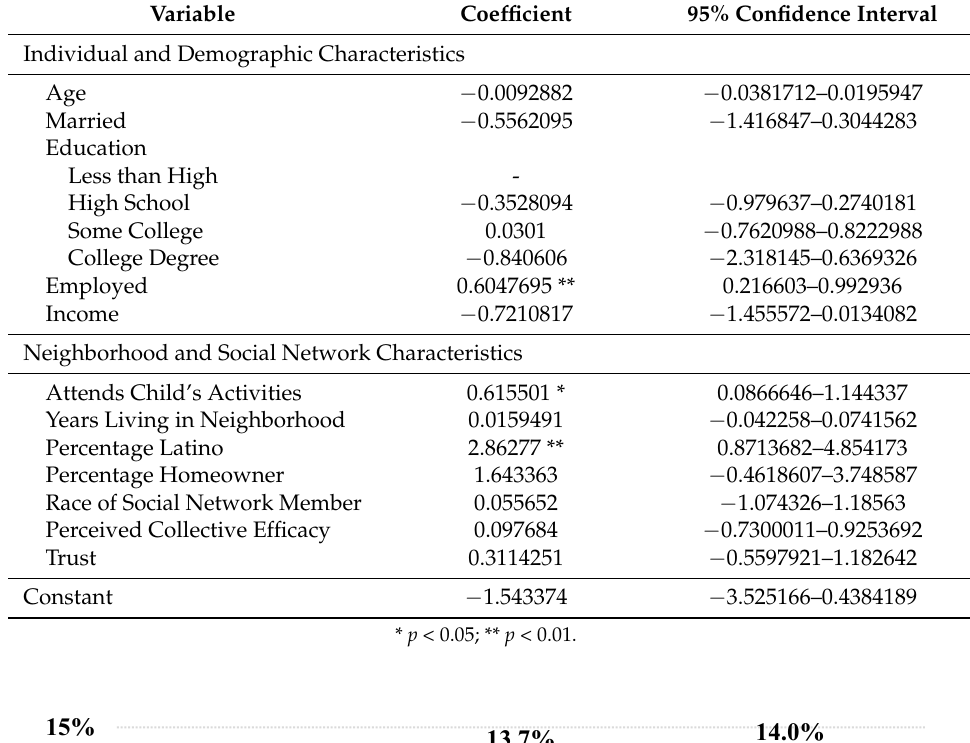
Table 3. Logistic Results of Puerto Rican Mothers’ Social Capital Accumulation.